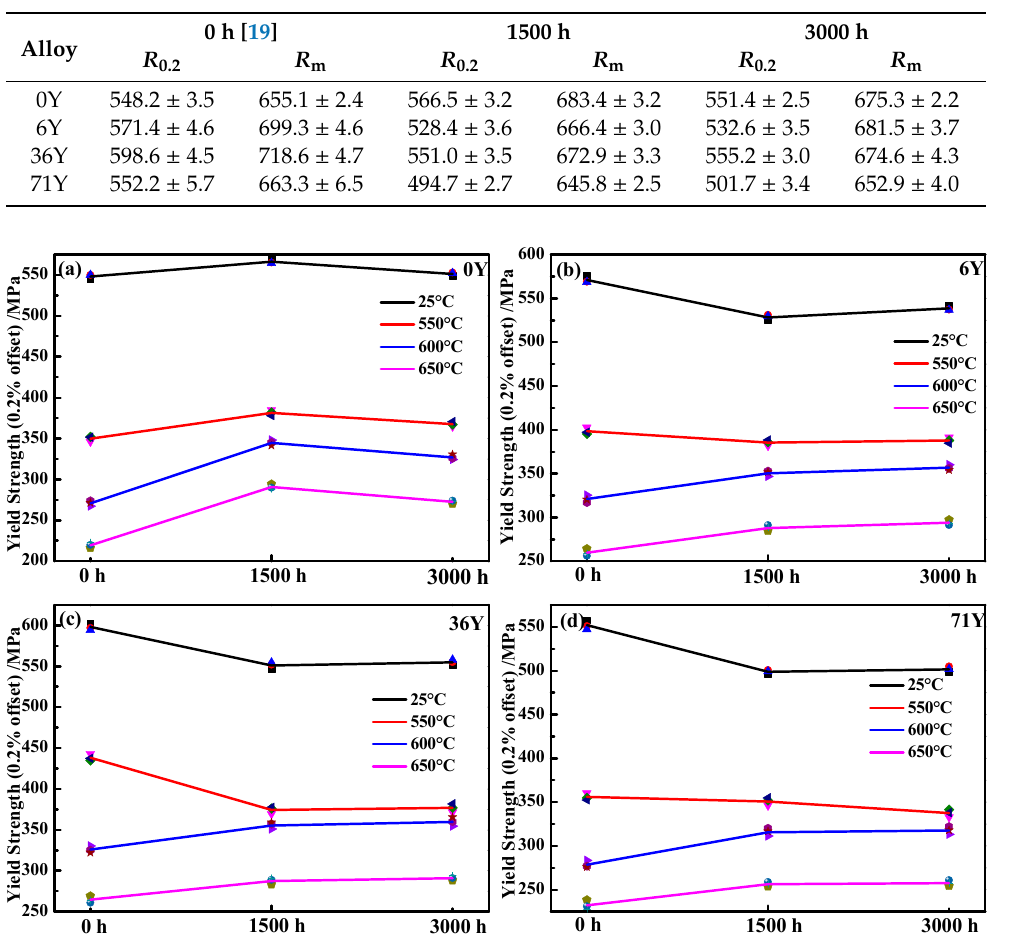
Table 5. Tensile properties of the alloys at room temperature (MPa).